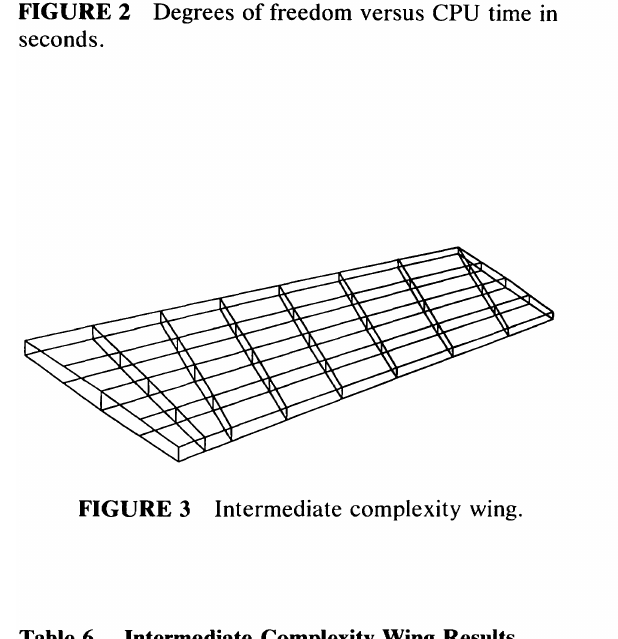
Table 6. Intermediate Complexity Wing